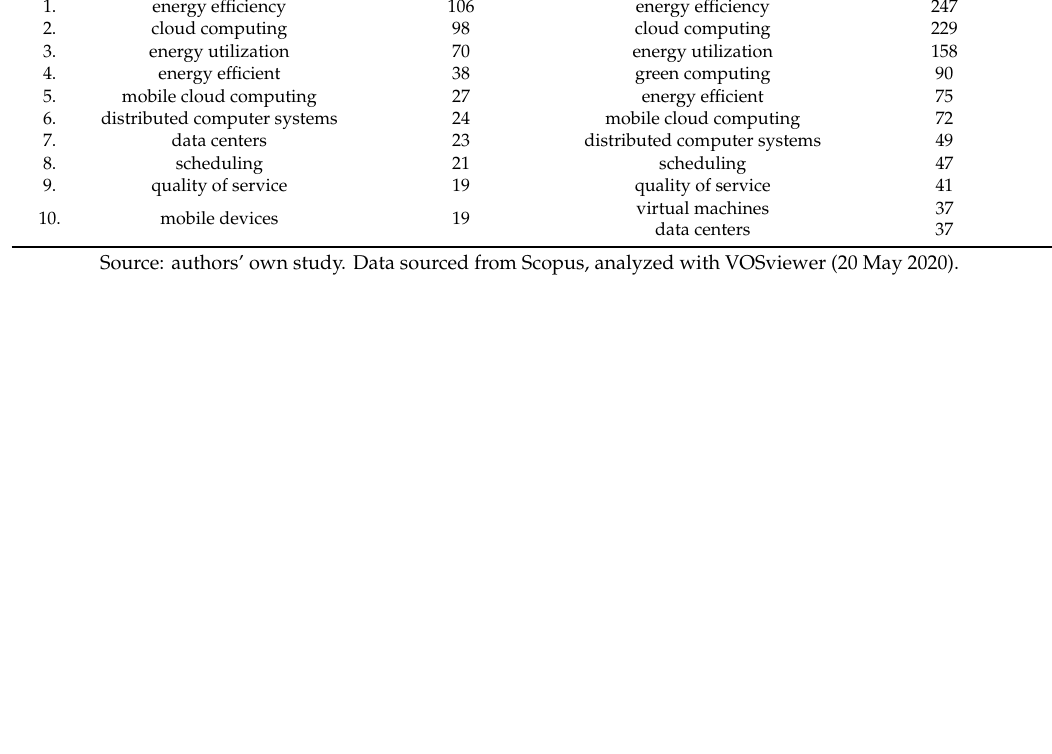
Figure 3. High-frequency keywords in research on cloud computing energy efficiency. Source: authors’ own study. Data sourced from Scopus, analyzed with VOSviewer (20 May 2020). Table 5. High-frequency keywords in research on cloud computing energy efficiency. Rank